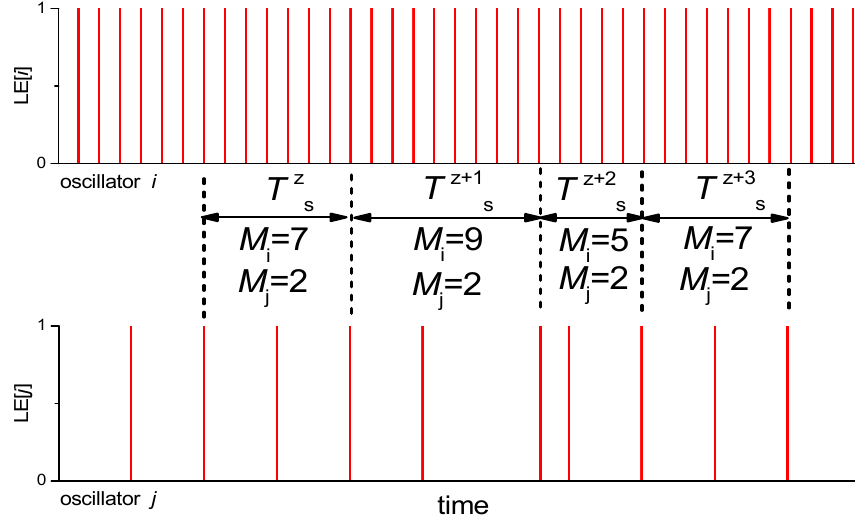
Figure 7. Arrays LE[ i ] and LE[ j ] for two oscillators with a non-constant period of synchronization T z s .